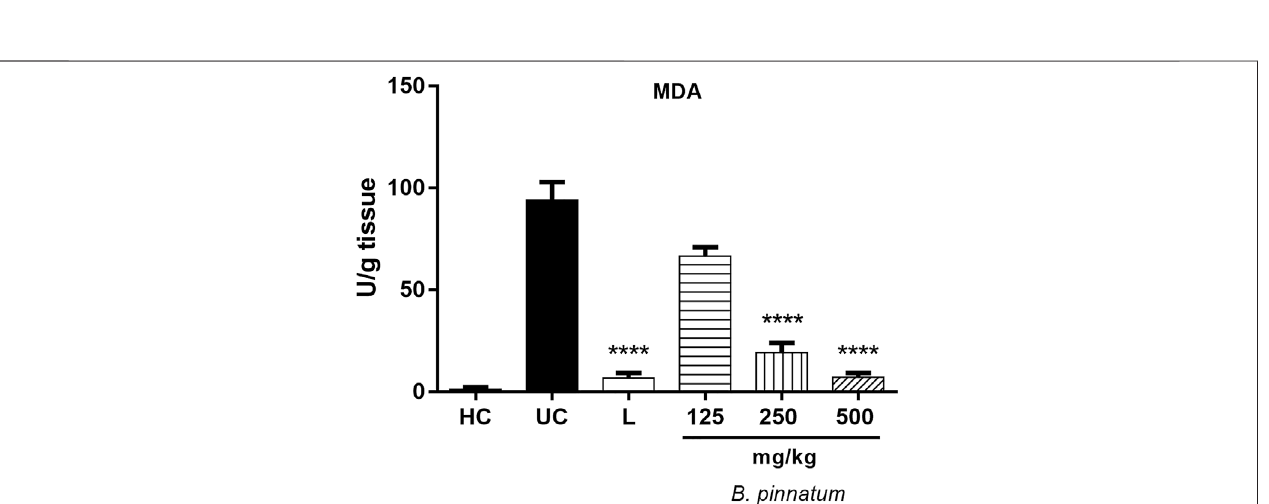
Frontiers in Pharmacology |